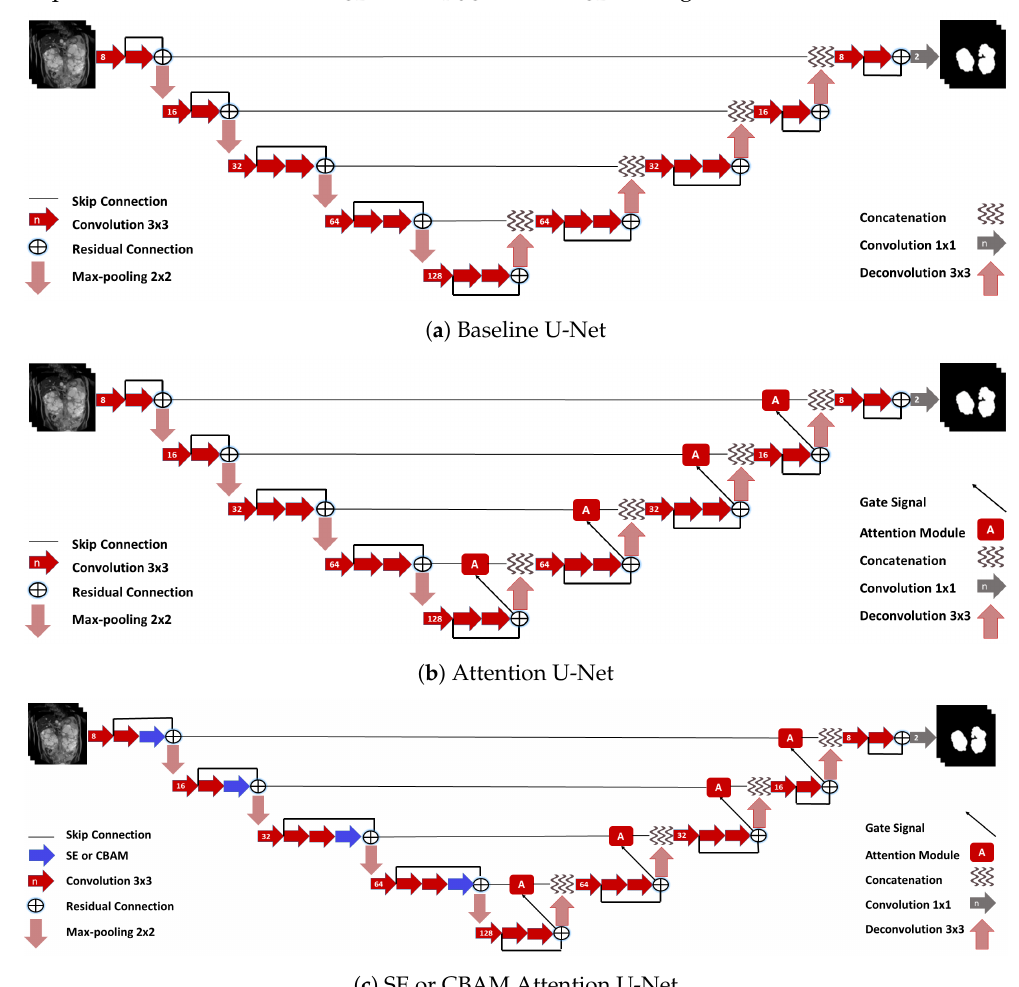
Figure 4. The network architectures for kidney segmentation: ( a ) baseline U-Net without any attention modules, ( b ) U-Net with attention modules as described by Oktay et al. [21] and ( c ) U-Net combining SE or CBAM [22,23] with attention modules from